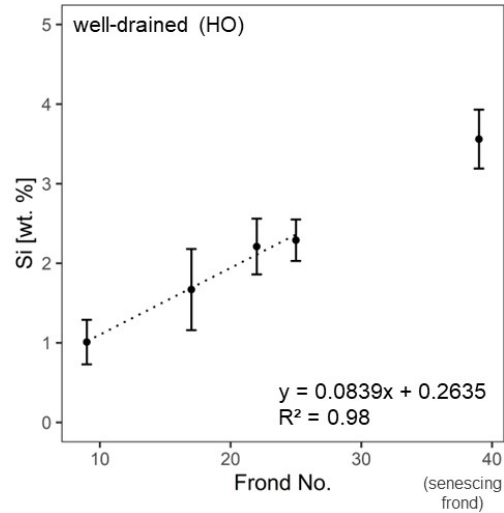
Figure 3. Si concentrations in leaflets of five mature oil-palm fronds (nos. 9, 17, 22, and 25, senescing palm frond) from well-drained